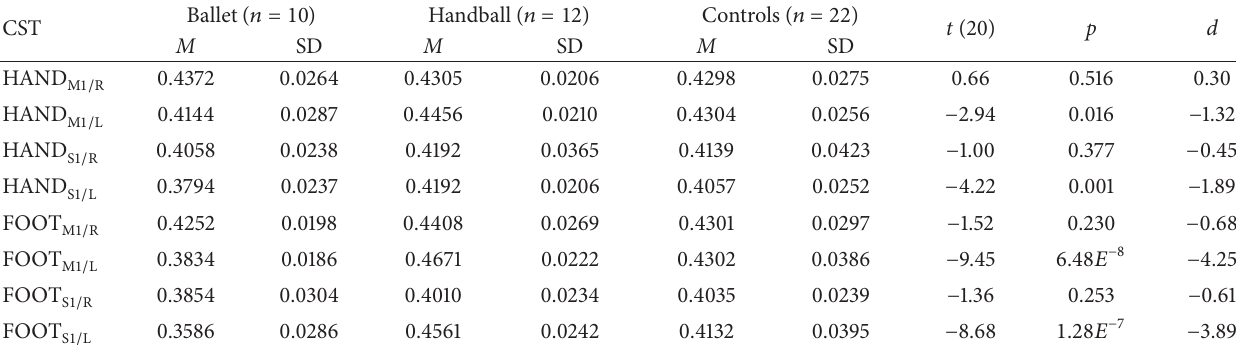
Table 4: Group comparisons of fractional anisotropy (FA) in the respective corticospinal tracts (CST).